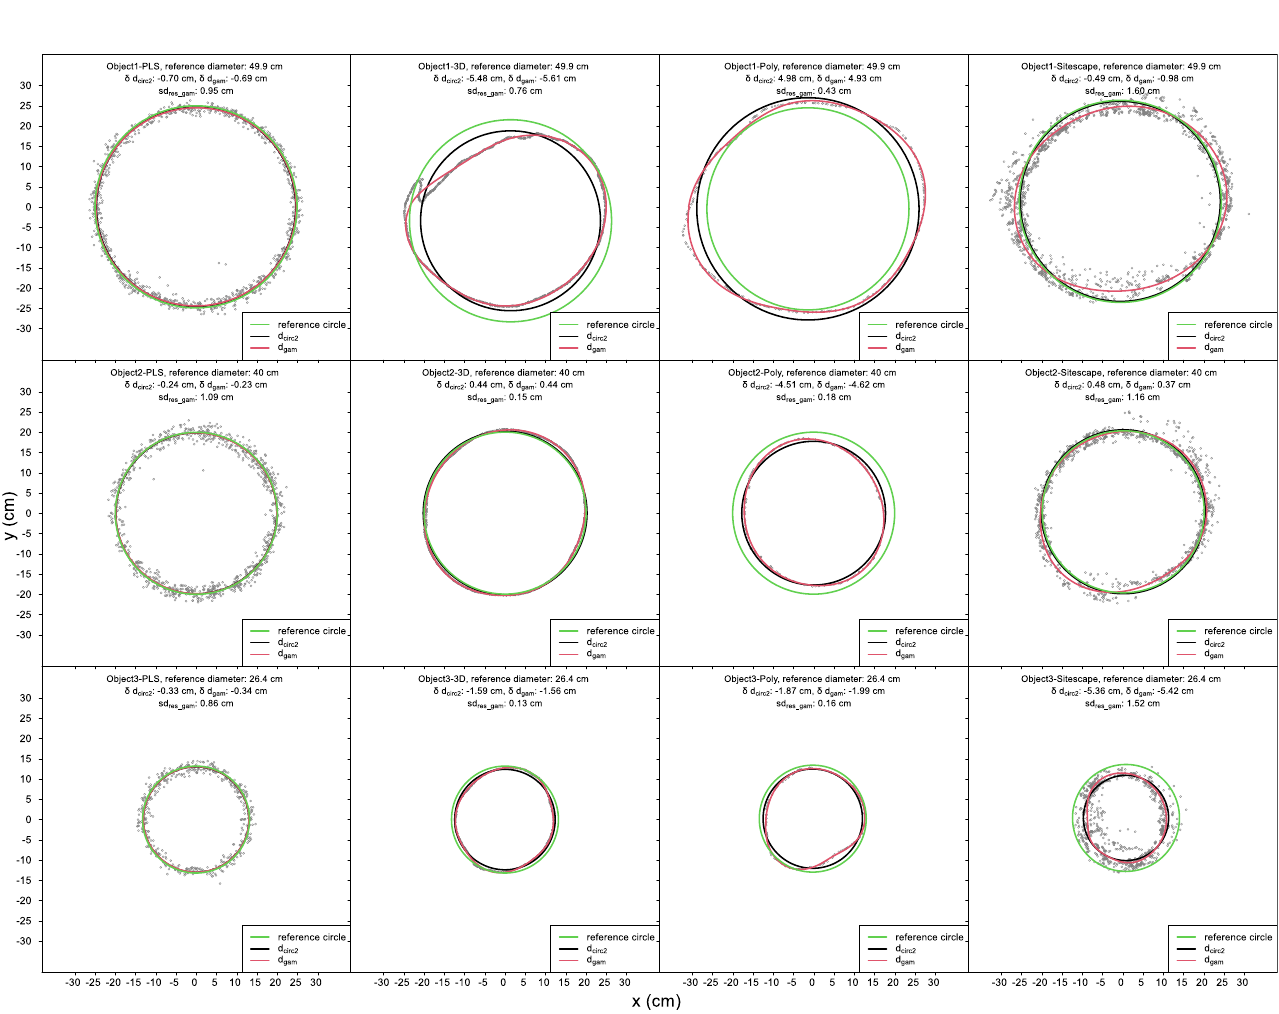
Figure A1. Overview of three object cross-sections, including the fitted diameters, deviations, and standard deviations of the residuals. The solid red and black circles indicate the diameter d gam and d circ2 , respectively. The solid green circle indicates the diameter of the reference circle.